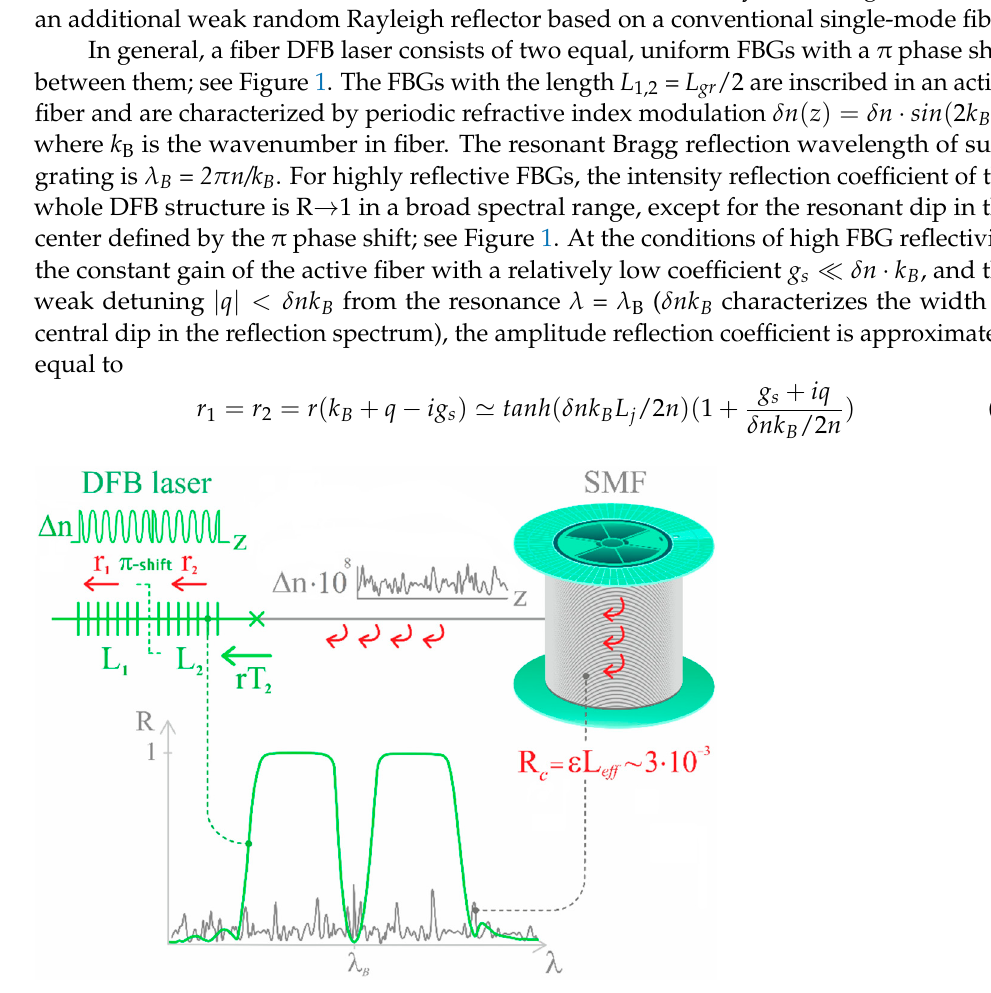
Figure 1. Basic scheme of hybrid configuration with DFB fiber laser and 25 km SMF spool.